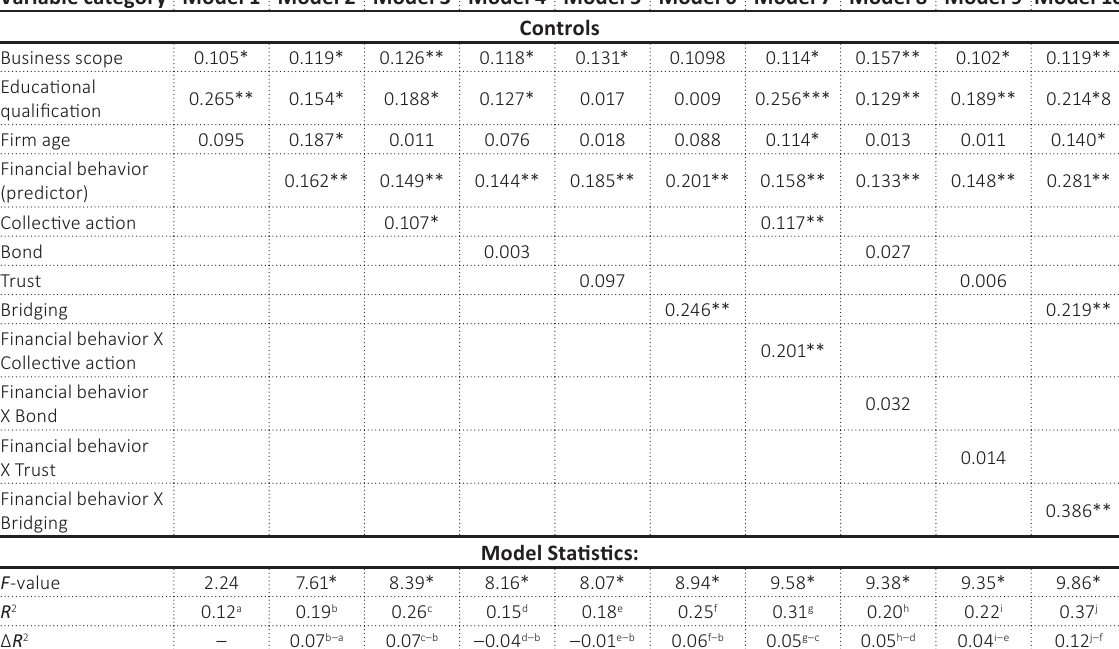
Table 2. Results on the main and moderating